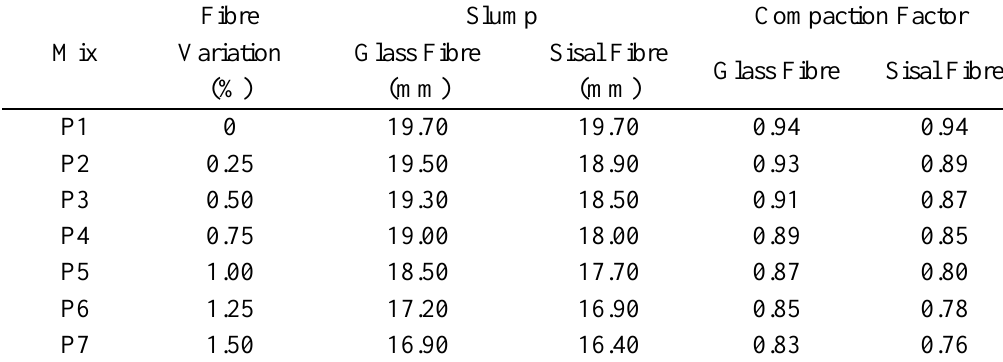
Table 2. Workability of the fibre